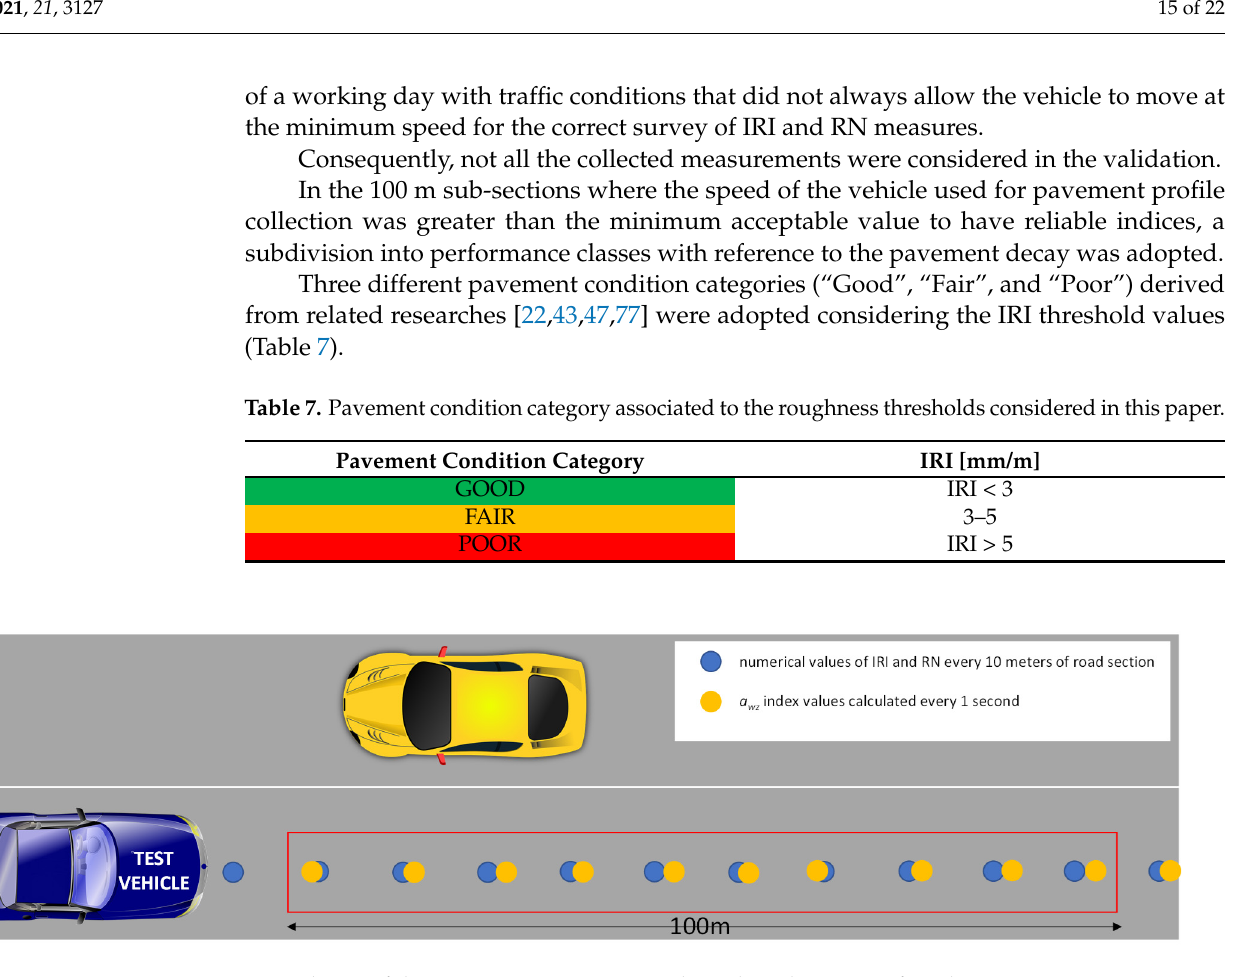
Figure 11. Scheme of the measurement positions along the sub-section of road.